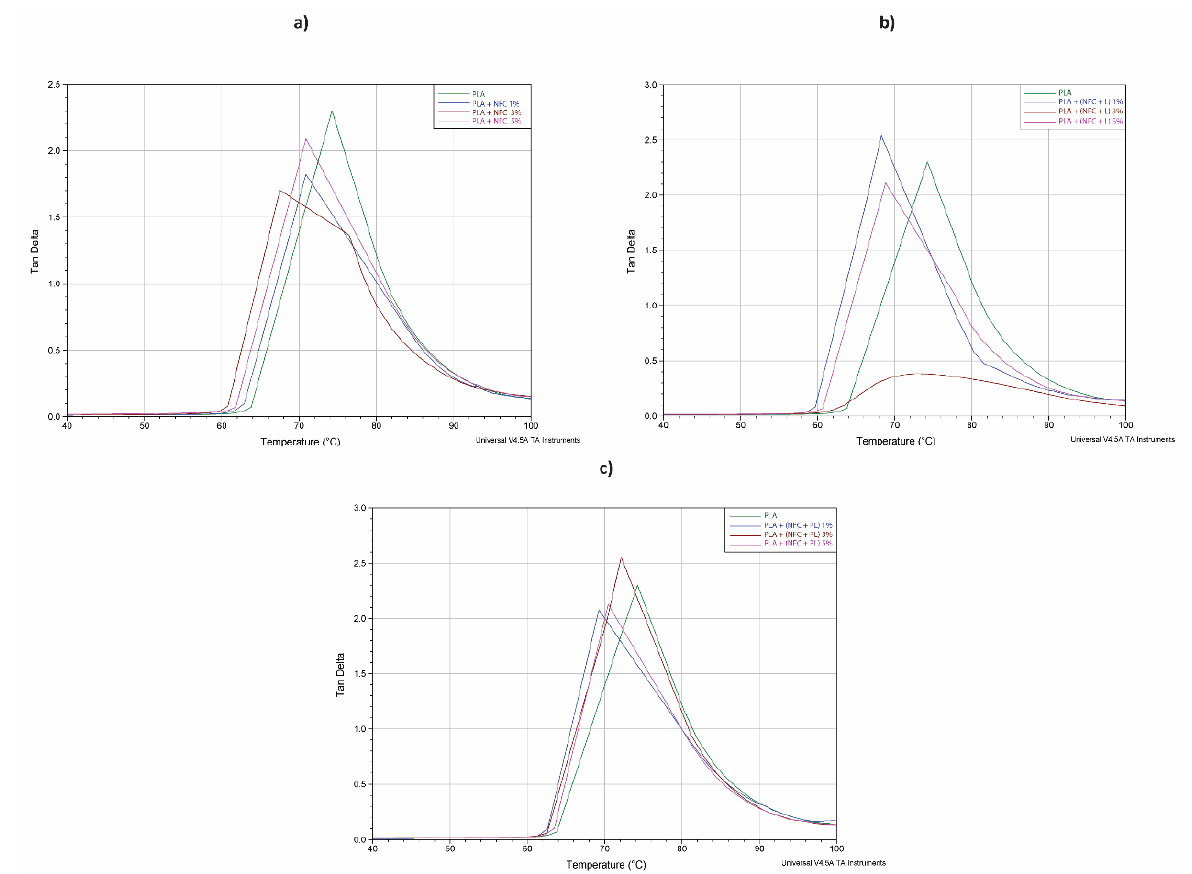
Figure 11. Loss factor (tan δ ) vs. temperature at 10 Hz of oscillation of samples in groups ( a ) GR1, ( b ) GR2, and ( c ) GR3.